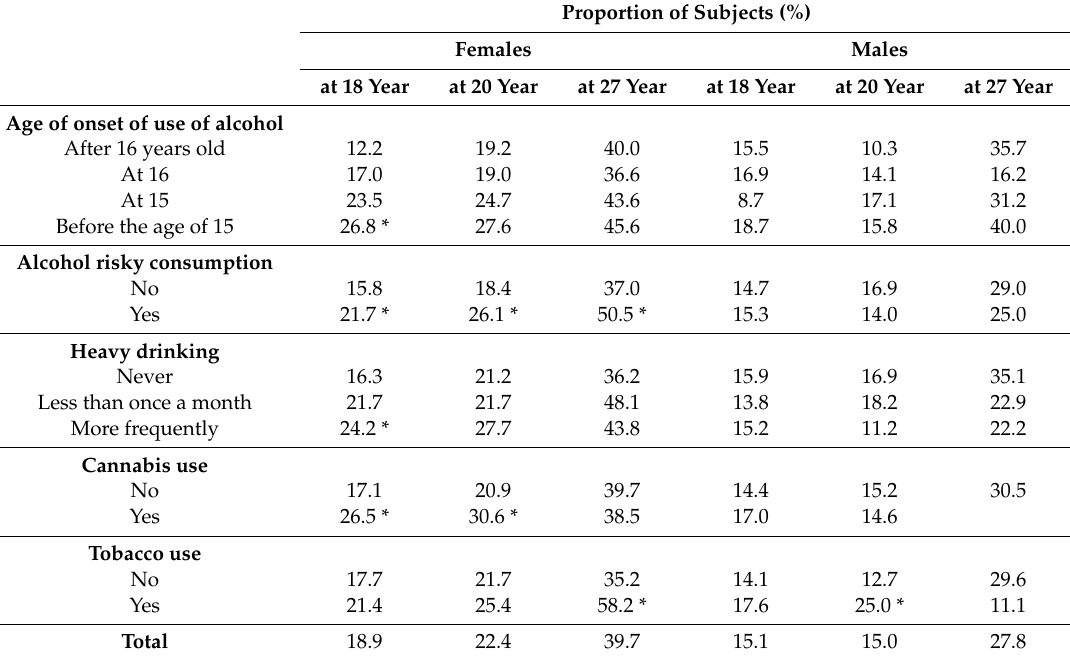
Table 3. Prevalence of non-medical use of prescription drugs at 18, 20, and 27 years old in relation to the substance use profiles of the subjects.